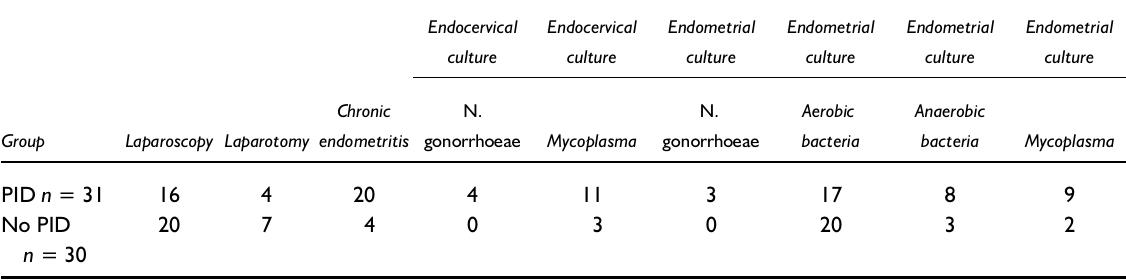
Table 5 Number of patients with surgical visualization of pelvis and endometrial results according to PID or not